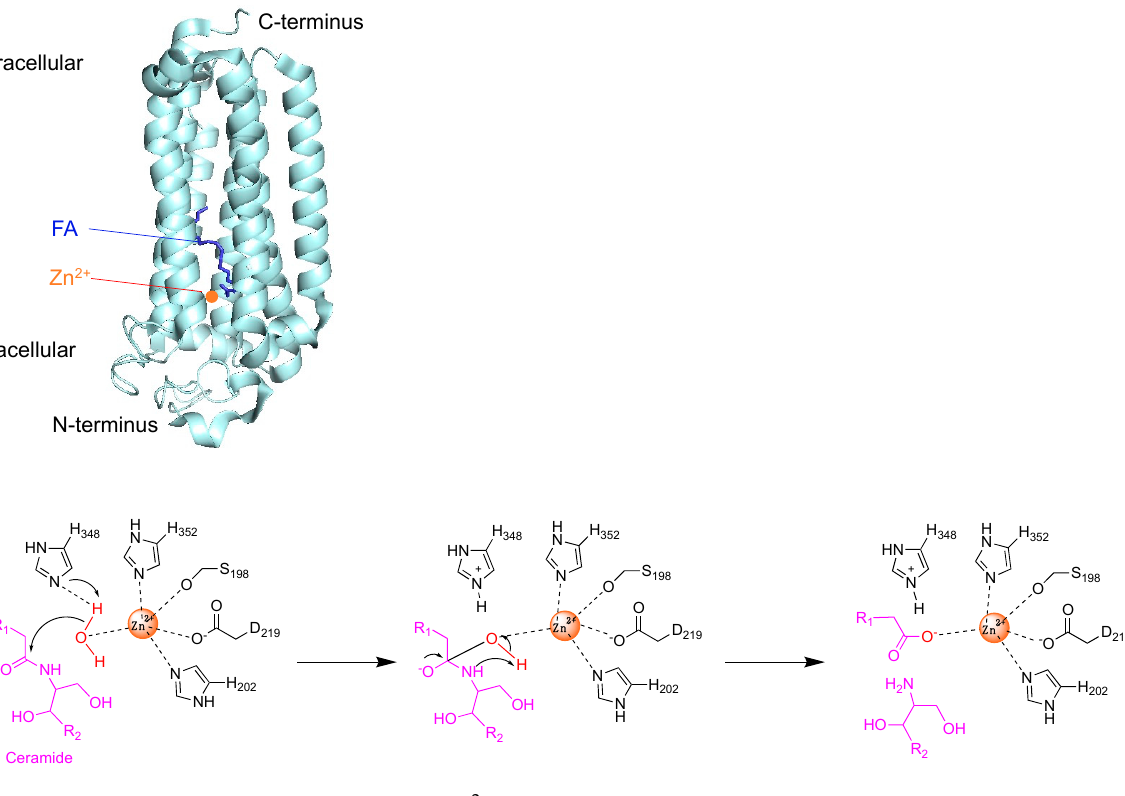
Figure 2. ADIPORs are Zn 2+ -dependent ceramidases. ( A ) X-ray crystal structure of ADIPOR2 in complex with a fatty acid (FA) and Zn 2+ . Based on PDB structure 5LX9. ( B ) Proposed catalytic mechanism of ADIPOR2 ceramidase activity. Zn 2+ activates a water molecule to attack the amide carbonyl group to form a tetrahedral intermediate. Based on